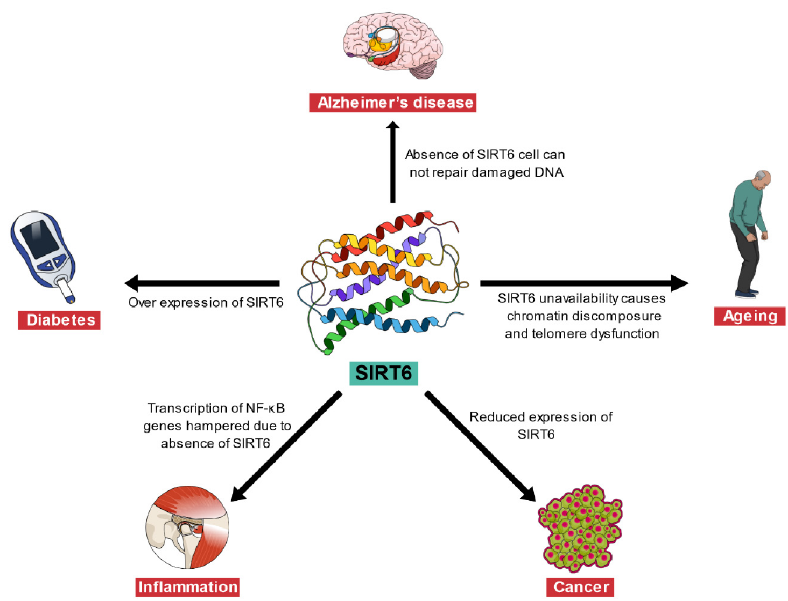
Figure 1. Sirtuin 6 (SIRT6) and its association with different